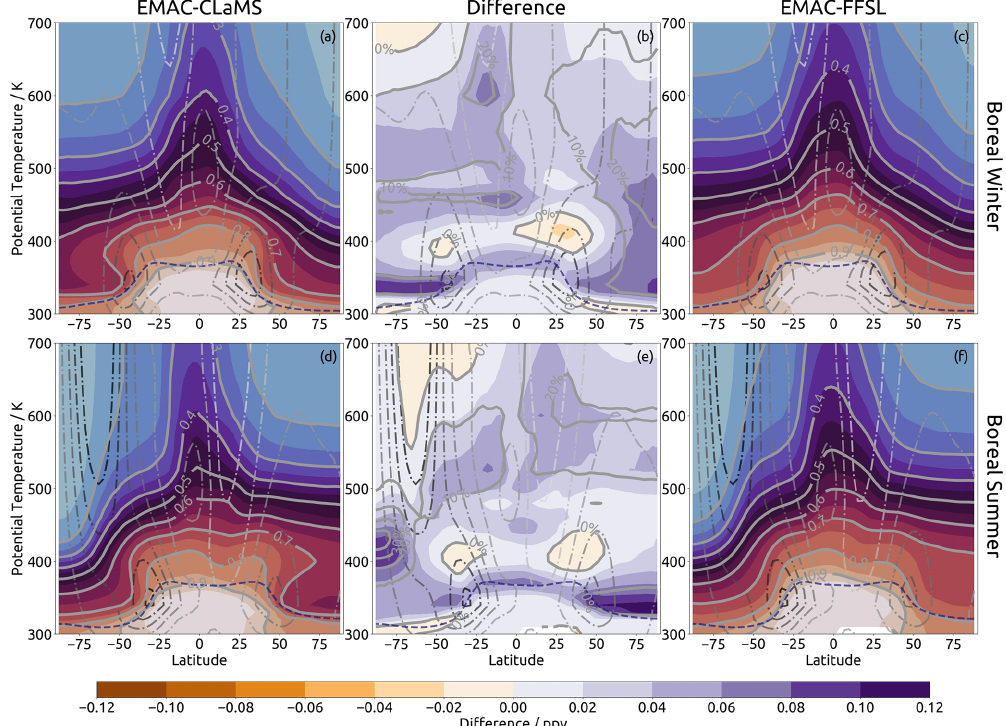
Figure 2. Same as Fig. 1 but the quantity examined is a “forward-tracer” of 2-year lifetime (see text for details), with the exception that the percentage differences shown in (b) and (e) use EMAC-CLaMS as the baseline (i.e., 30% means that EMAC-FFSL results show 30% more forward tracer than those of